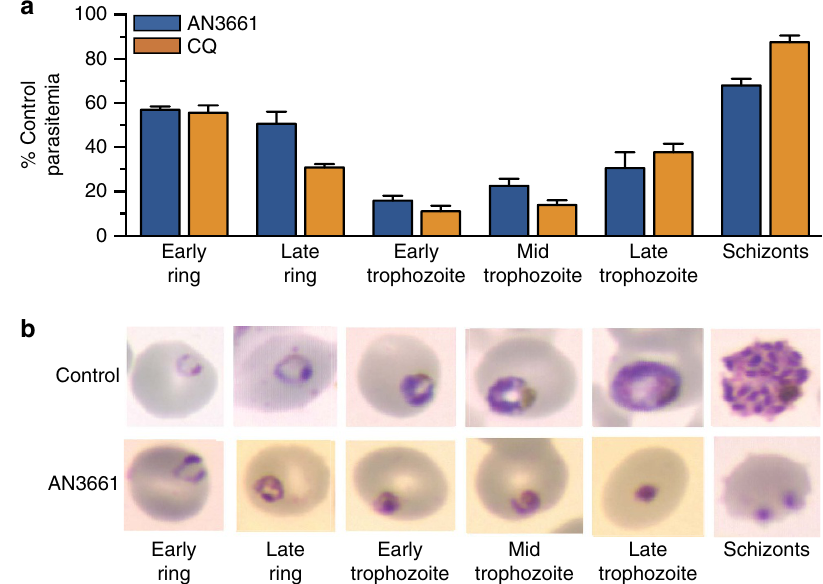
Figure 3 | Stage specificity of AN3661. ( a ) W2 parasites were treated with 370nM AN3661 or 1.3 m M chloroquine (CQ) for 8-h time intervals across the asexual erythrocytic cycle. Compounds were removed at the end of each 8h interval, cultures were continued and parasitemias were determined after 48h. Bar graphs indicate the mean ± s.e.m. parasitemia of treated parasites as a percentage of untreated controls. ( b ) W2 parasites treated with 370nM AN3661 beginning in the early ring stage and untreated controls were collected at the indicated time points, stained with Giemsa, and